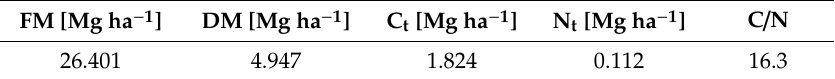
Table 2. Mean values (n = 4 subsamples) of fresh matter (FM), dry matter (DM), total C (C t ), total N (N t ) and C / N-ratio (C / N) of sugar beet residues (leaves and crowns